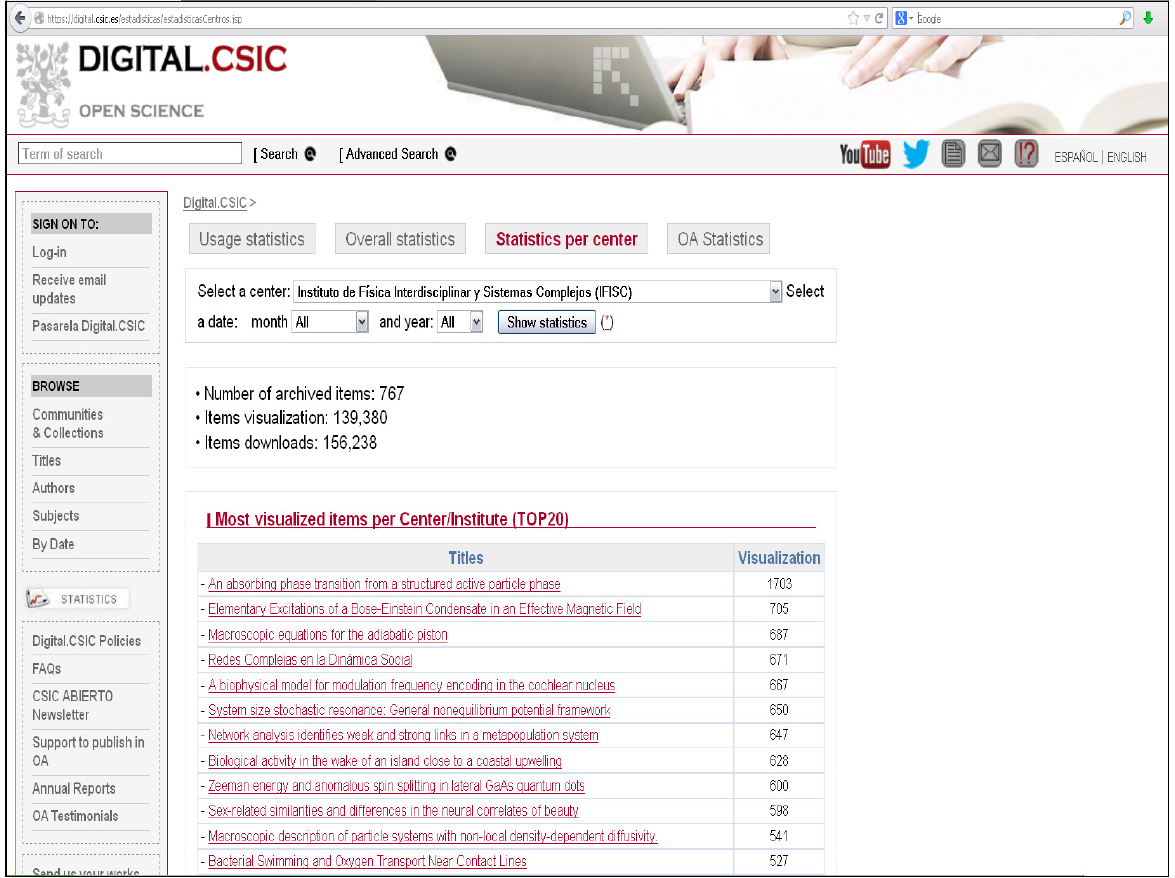
Figure 3. Statistics provided at CSIC institute level. Details include total number of items; monthly and yearly deposits; monthly, yearly and total downloads and views; CSIC staff (researchers, librarians) who upload the most per month and year; 20 most downloaded and viewed works per institute. Source: DIGITAL.CSIC Institute level